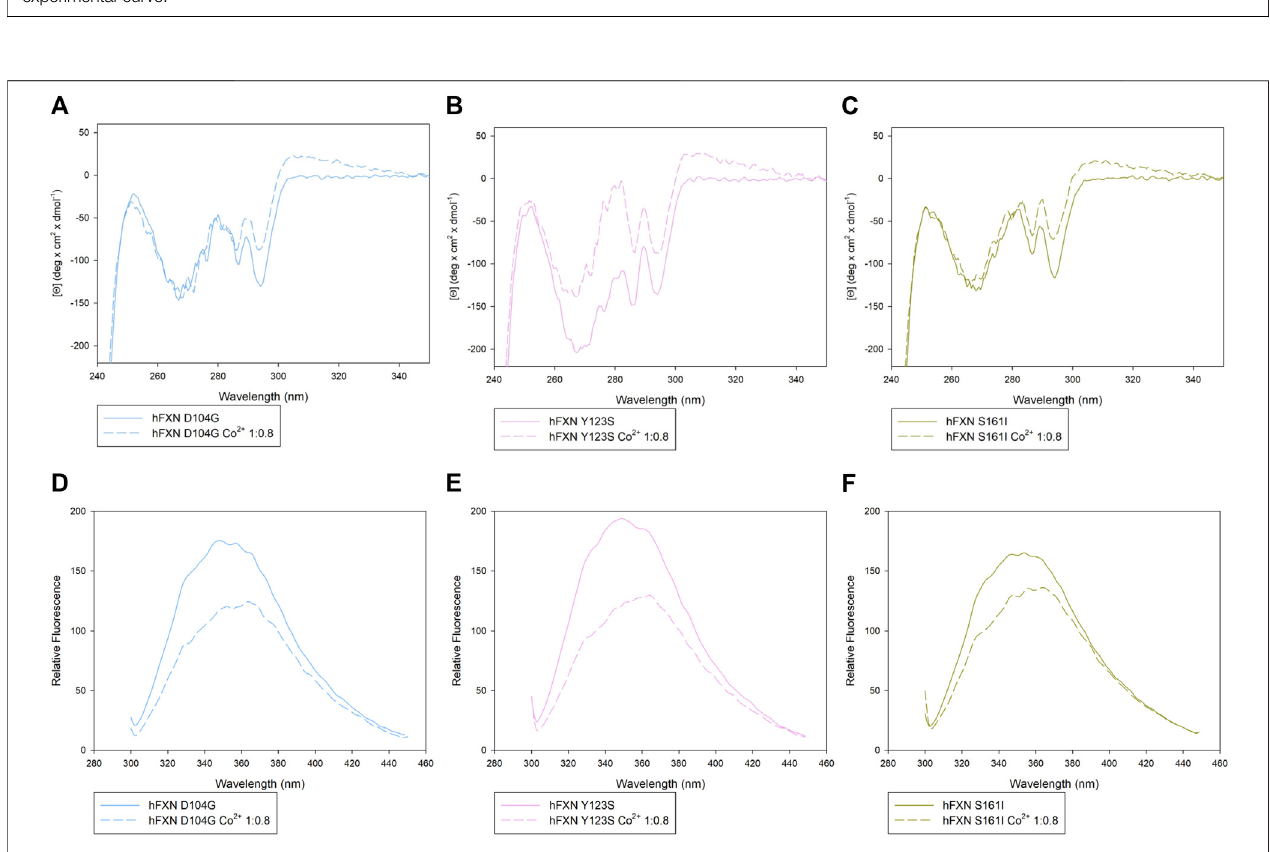
FIGURE 4 | Spectroscopic characterization of the D104G, Y123S, and S161I variants with and without Co 2+ . Upper panels: near-UV CD spectra of D104G (light blue, A ), Y123S (light pink, B ), and S161I (dark yellow, C ) in the absence of Co 2+ (continuous line) and in the presence of 0.8 Co 2+ equiv (dotted line). Lower panels: intrinsic fl uorescence emission spectra of D104G (light blue, D ), Y123S (light pink, E ), and S161I (dark yellow, F ) in the absence of Co 2+ (continuous line) and in the presence of 0.8 Co 2+ equiv (dotted line). Fluorescence spectra were monitored at 50 μ g/ml under identical excitation and emission conditions.